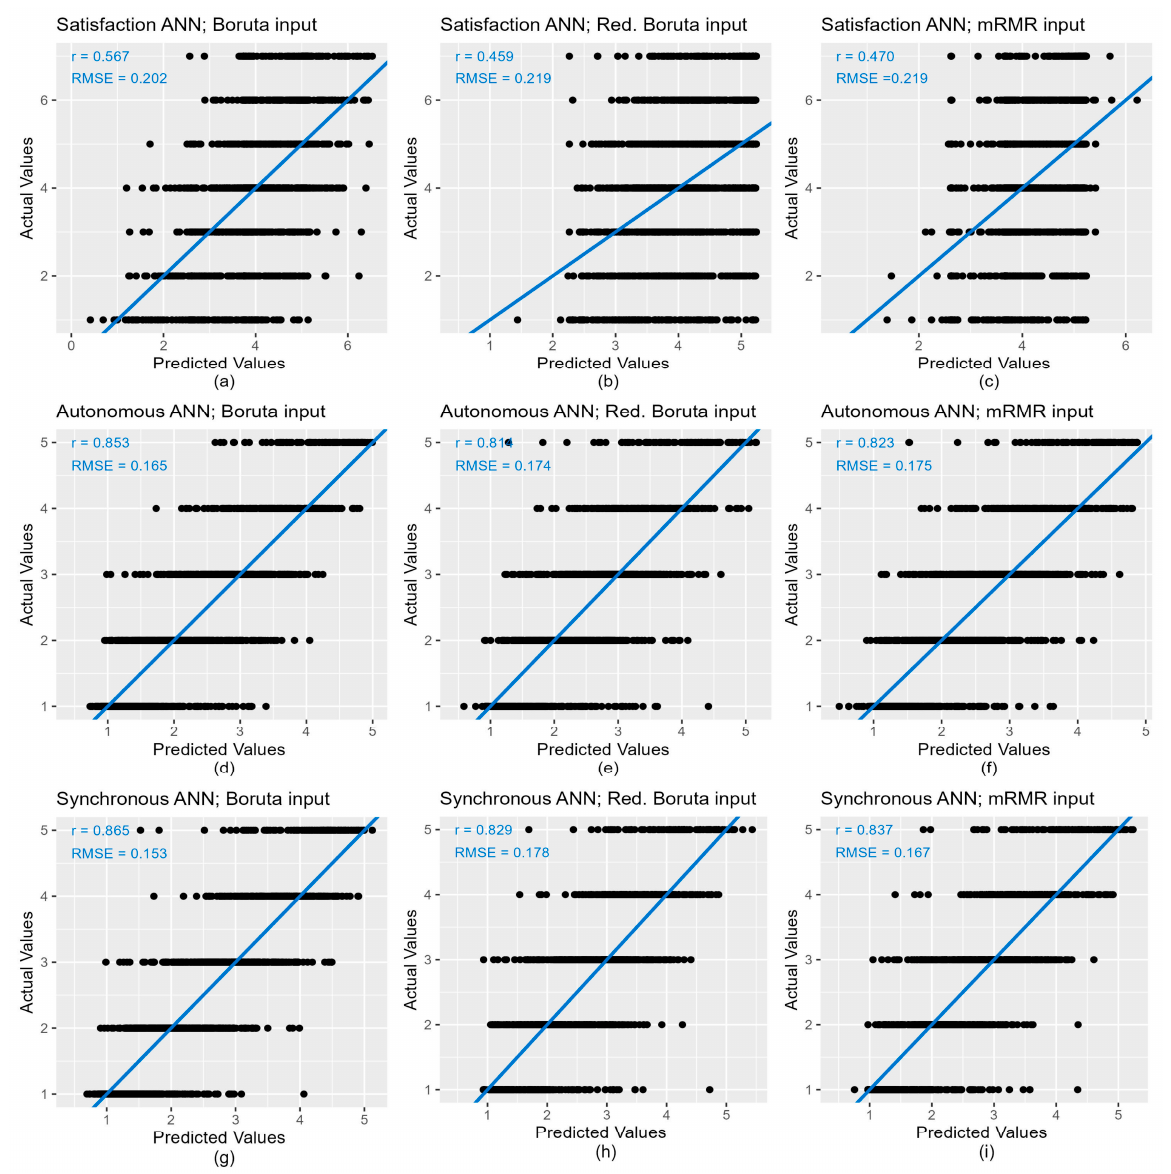
Figure 11. Predicted versus actual values of the ANNs under study, according to the training data set. The title of each subgraph indicates the predicted variable (satisfaction with the online learning— first row ( a – c ); noise interference with autonomous activities— second row ( d – f ); and noise interference with synchronous activities— third row ( g – i )), and the input features selected (with Boruta method— first column ( a , d , g ); with reduced Boruta— second column ( b , e , f ); and with mRMR method— third column ( c , f , i )). The blue line is the estimated regression line. The correlation coefficients (r) and root mean square errors (RMSEs) are shown in the top-left corner of each